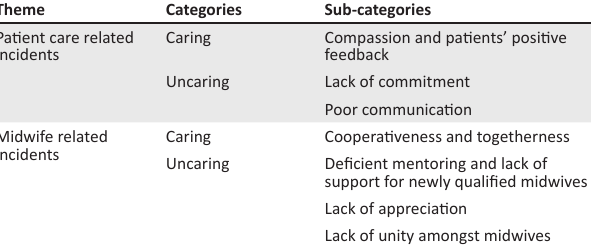
TABLE 1: Themes, categories and sub-categories from the questionnaire and focus